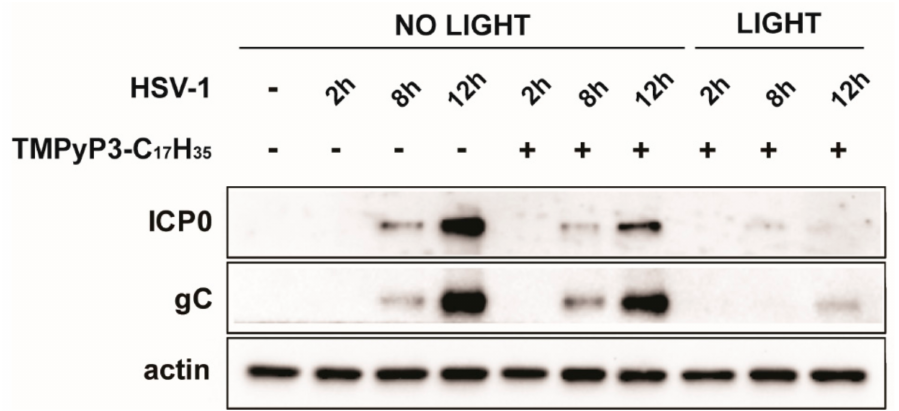
Figure 6. TMPyP3-C 17 H 35 reduces levels of immediate early and late proteins. Vero cells were pretreated with 1.2 µ M concentration of TMPyP3-C 17 H 35 , infected with MOI 1, and TMPyP3-C 17 H 35 activated or not activated with light. Samples were collected at 2 h, 8 h, and 12 h post infection and probed by immunoblotting with antibodies against viral immediate–early protein ICPO and late protein